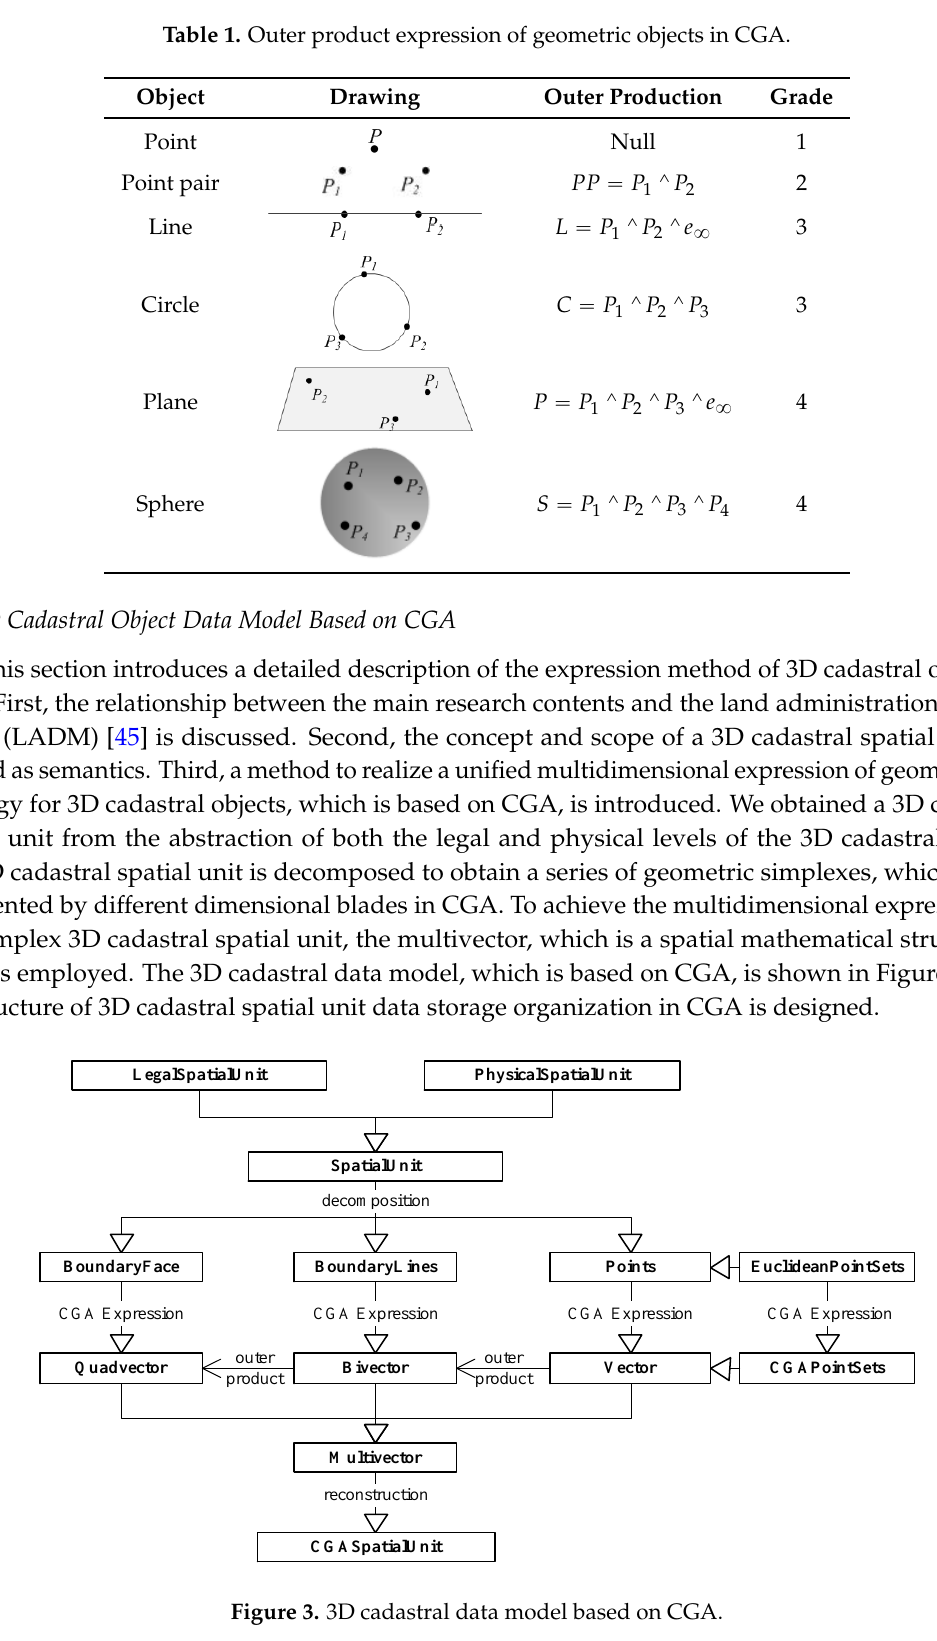
Figure 3. 3D cadastral data model based on CGA.